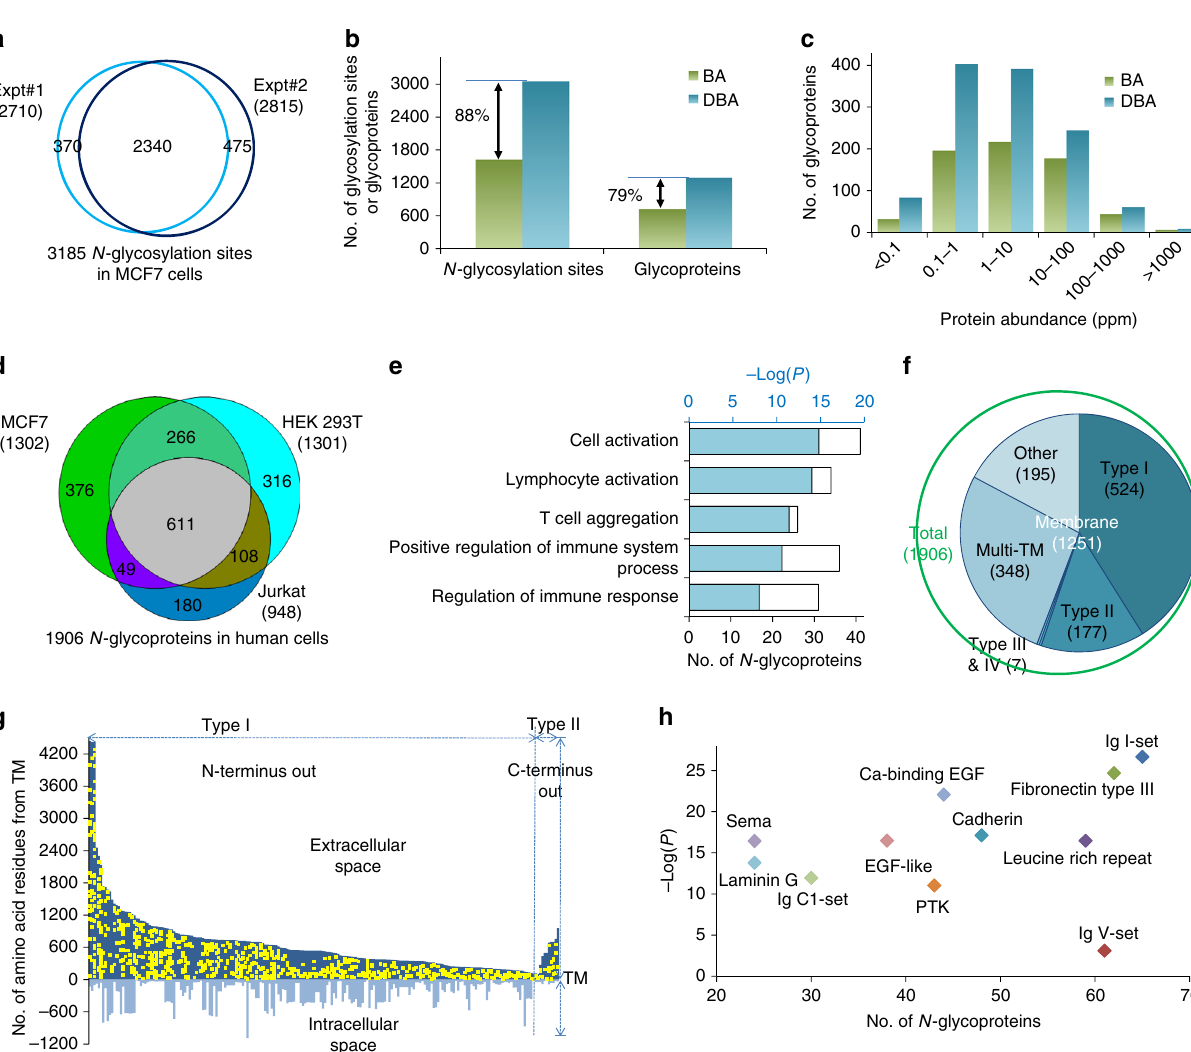
Fig. 5 Comprehensive analysis of protein N -glycosylation in human cells. a Comparison of unique protein N -glycosylation sites identi fi ed in MCF7 cells in duplicate experiments. b Comparison of unique glycosylation sites and glycoproteins identi fi ed with the boronic acid derivative magnetic beads (designated as BA, shown in green) and with the dendrimer beads conjugated with the boronic acid derivative (DBA) (blue). c Abundance distributions of N - glycoproteins identi fi ed with the BA (green) or DBA (blue) beads. d Overlap of N -glycoproteins in three different types of cells (MCF7, HEK 293T, and Jurkat). e Protein-clustering results for 180 N -glycoproteins identi fi ed exclusively in Jurkat cells. f Distribution of membrane proteins (type I, II, III, and IV, and multi-pass transmembrane (TM)) among all identi fi ed N -glycoproteins. g N -glycosylation site locations on 301 receptors with X -axis as the TM domain. Each glycoprotein sequence was aligned against the transmembrane domain, and the glycosylation sites are indicated as yellow dots. All sites are located in the extracellular space. h Domain analysis of N -glycoproteins showing the number of N -glycoproteins containing the most highly enriched domains and their corresponding P